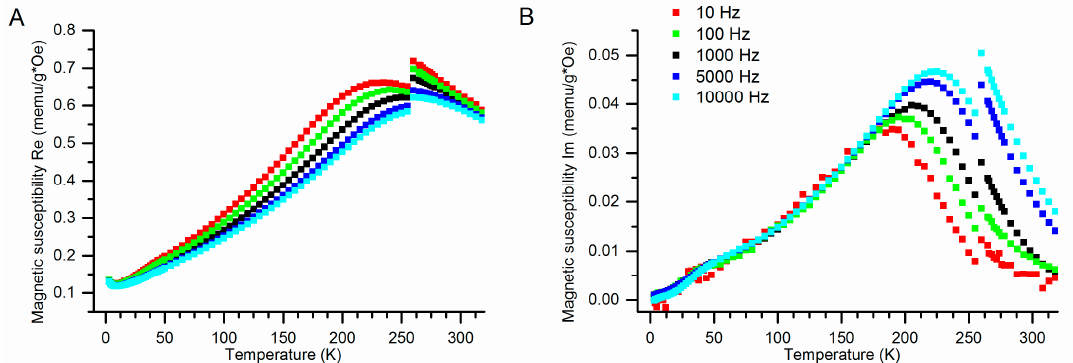
Figure 4. Temperature dependencies of the ( A ) dispersion part of magnetic susceptibility for a water suspension of SPION-CCh-B nanoparticles at various frequencies; ( B ) absorption part of magnetic susceptibility for an aqueous suspension of SPION-CCh-B nanoparticles at various frequencies.